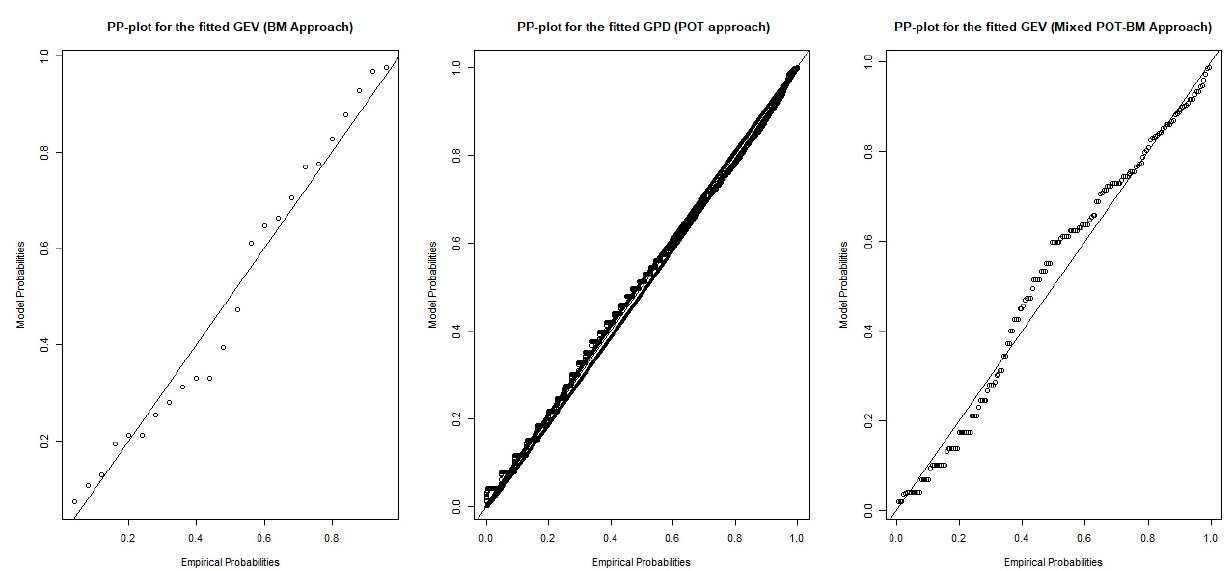
Figure 6. PP plot for each fitted model.